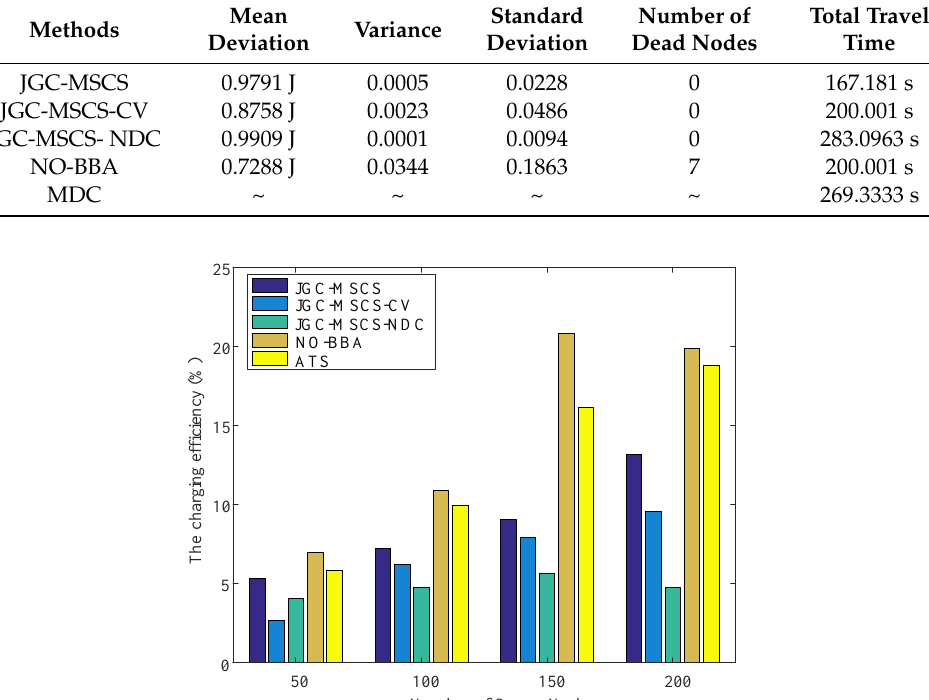
Table 3. Comparison table of remaining energy of nodes.